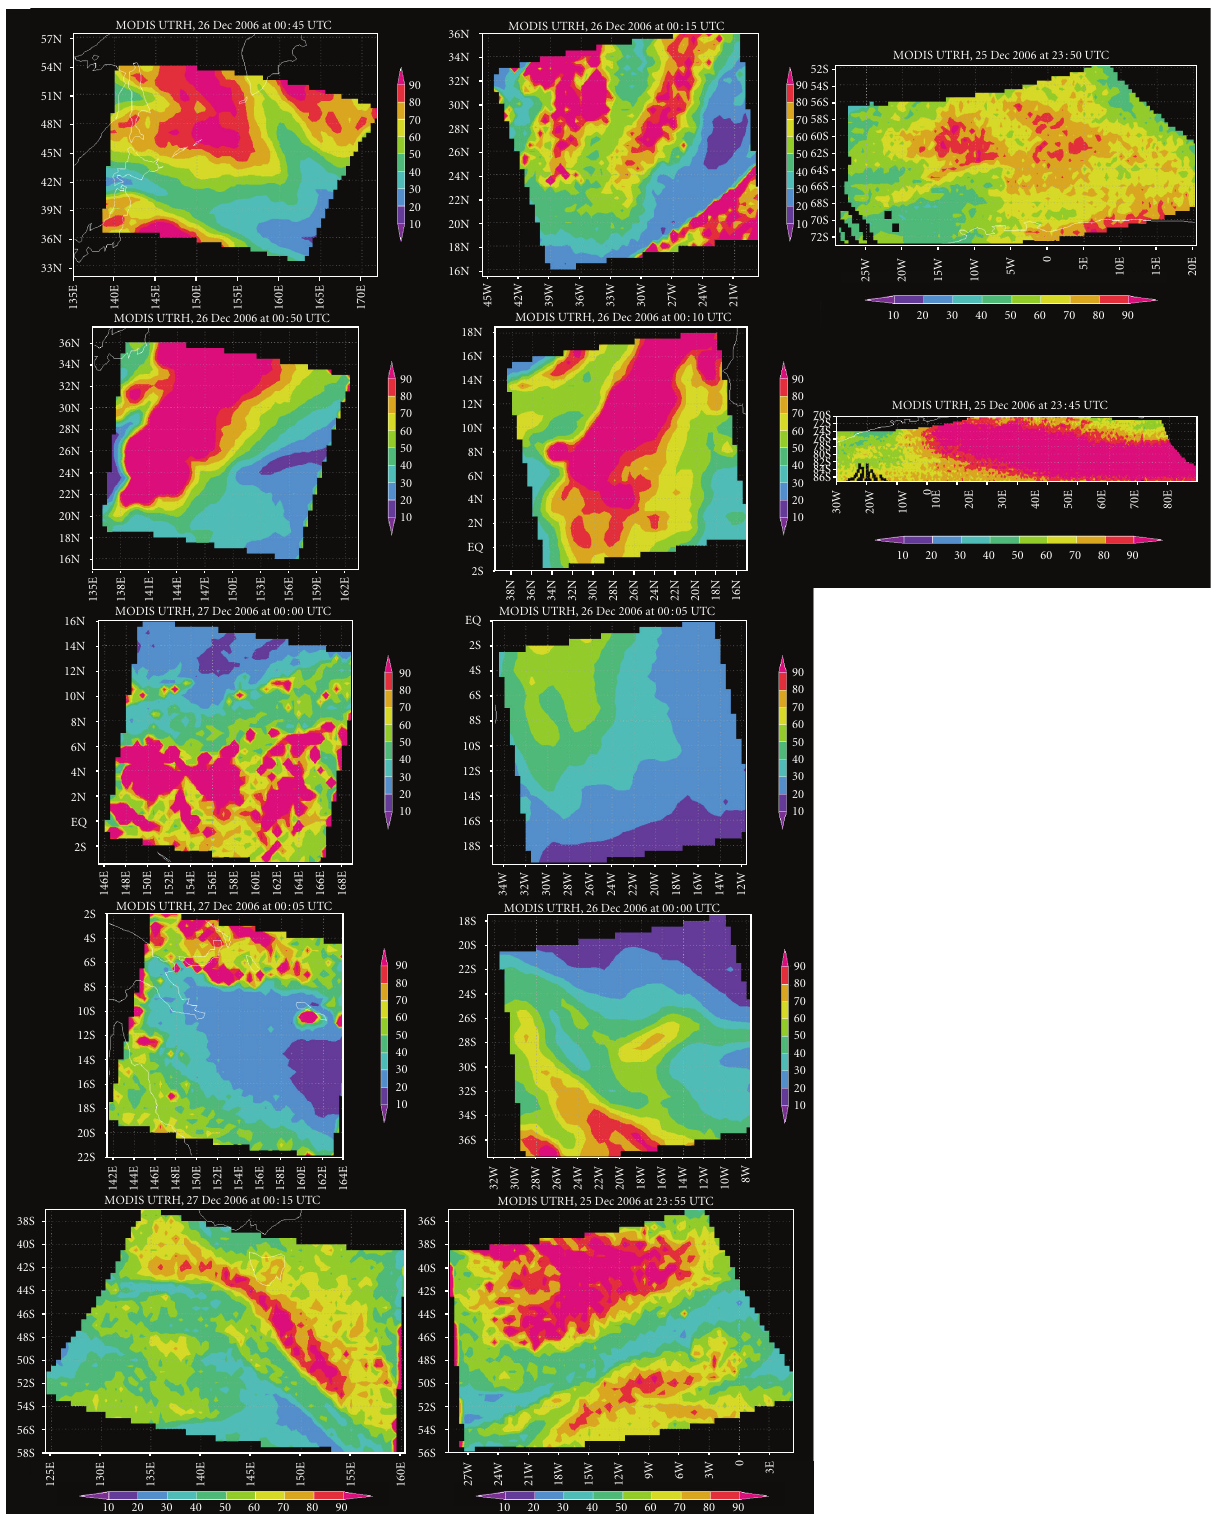
Figure 2: Same as Figure 1 but for the upper tropospheric relative humidity